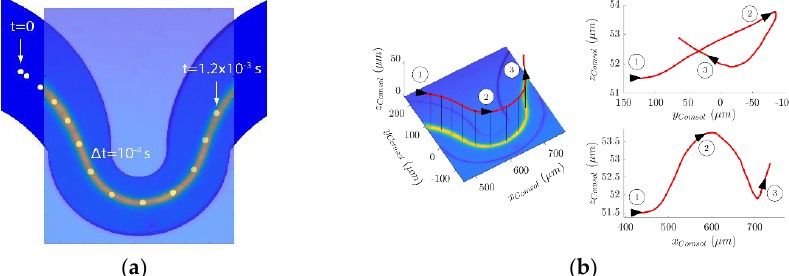
Figure 9. ( a ) Overlapping of the experimental image for a focused streak of Φ = 10 μm particles and positions of the particle calculated with the FSI simulation along the small (white circles). The overlapped image is represented in false color to improve the visibility of the streak; ( b ) Composed perspective of the 3D trajectory of the particle (red line).